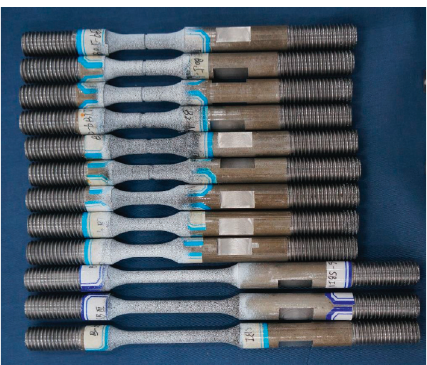
Figure 6: The specimens with speckle spots.